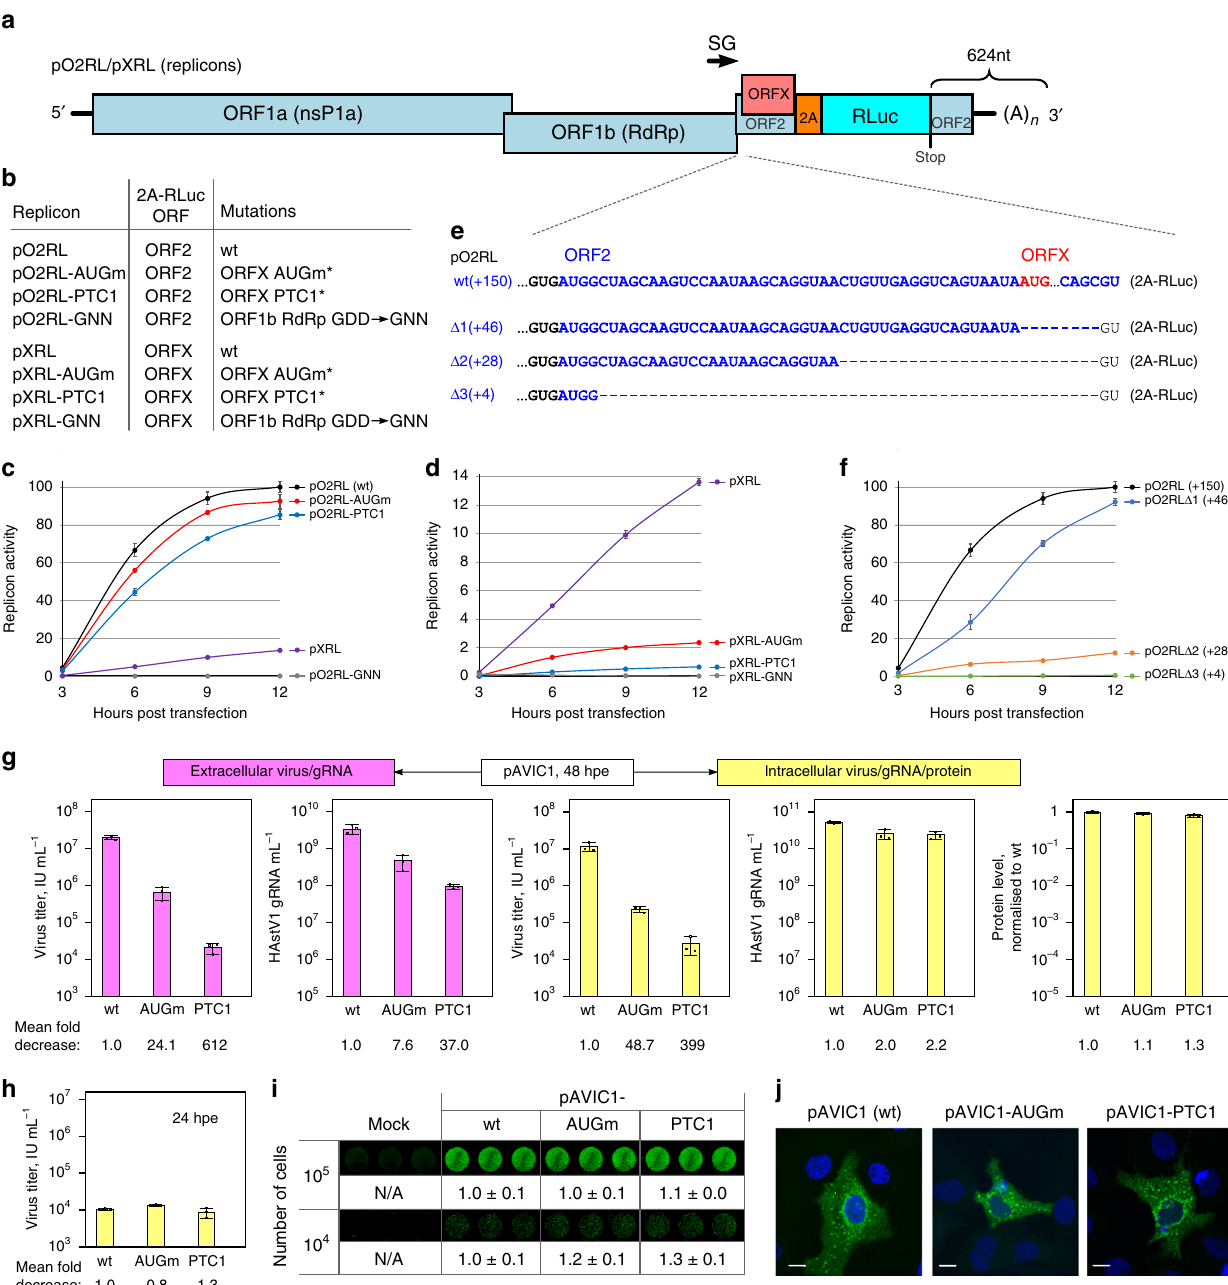
Fig. 4 Analysis of replication stages affected by XP. a Schematic of the astrovirus replicon. The 2A-RLuc cassette is fused in either the ORF2 (pO2RL) or ORFX (pXRL) reading frame. b List of replicon mutants showing the RLuc reading frame and introduced mutations. Asterisk — see Supplementary Fig. 11 for exact sequences. c, d Relative replicon luciferase activities measured after RNA transfection of BSR cells (see Supplementary Fig. 13a, b for Huh7.5.1 cells). Values are normalized so that the maximum ORF2-frame wt value is 100%. e Schematic of deletion mutants in the pO2RL replicon; ORF2 (blue), ORFX initiation codon (red). f Relative replicon luciferase activities of deletion mutants (see Supplementary Fig. 13c for Huh7.5.1 cells). g Schematic design and results of experiment to quantify virus titer, RNA, and protein levels in released virions and infected cells. BSR cells were electroporated with pAVIC1-wt, -AUGm or -PTC1 T7 RNAs and incubated for 48 h. Clari fi ed supernatants were titrated ( fi rst graph) or treated with RNase I and used for viral RNA isolation and subsequent quanti fi cation by qRT-PCR (second graph). Cells were collected, freeze-thawed three times and titrated on Caco2 cells (third graph). Total RNA from infected cells was isolated and virus gRNA quanti fi ed by qRT-PCR (fourth graph). Aliquots of electroporated cells were seeded on a 96-well plate, incubated for 48 h, fi xed, permeabilized, stained with anti-CP antibody, and imaged by LI-COR followed by quanti fi cation using LI-COR software ( fi fth graph). h Cells were collected at 24 hpe, freeze-thawed three times and titrated on Caco2 cells. i Aliquots corresponding to 10 5 and 10 4 electroporated cells were seeded on a 96-well plate, fi xed at 24 hpe, permeabilized, stained with anti-CP antibody, and imaged by LI-COR followed by quanti fi cation using LI-COR software. j Huh7.5.1 cells were electroporated with pAVIC1-wt, -AUGm or -PTC1 T7 RNAs and incubated for 24 h. Representative confocal images of fi xed and permeabilized cells visualized for CP (green) and stained for nuclei (Hoechst, blue). Images represent z -stack projections. Scale bars are 10 µ m. Graphs show means± s.d. from n = 3 biologically independent experiments ( c , d , f , g , h ). Source data are provided as a Source Data fi le.